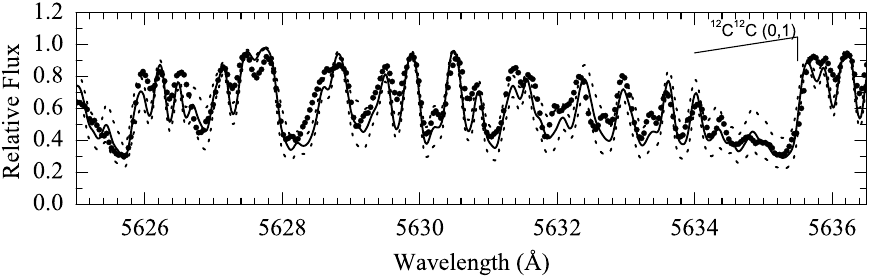
Fig. 9. The observed spectrum of HD 209621 in the wavelength range dominated by the C 2 Swan system (0,1) lines. The synthetic C 2 spectra are given for the three carbon abundances, log ϵ (C) = 7.85 ± 0.1.